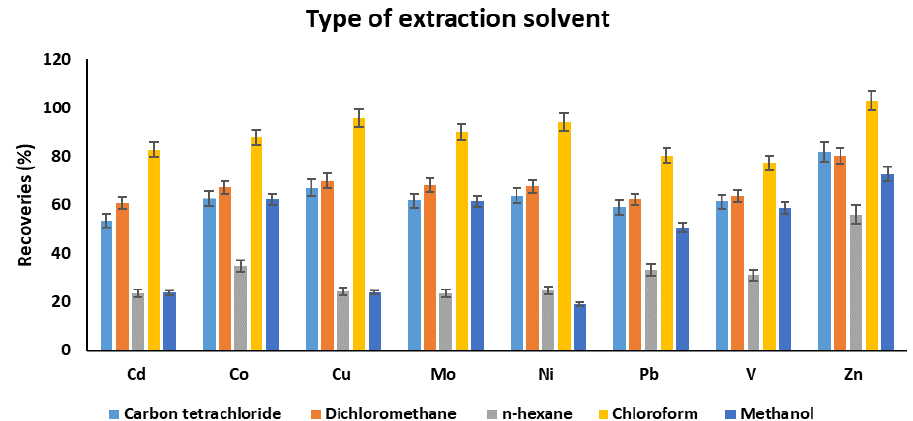
Figure 4. The effect of type of extraction solvent on the recoveries of target metals. Experimental conditions: sample pH: 4.5, volume of complexing reagent: 200 µL, volume of extraction solvent: 7.5 mL, extraction time: 30 min.